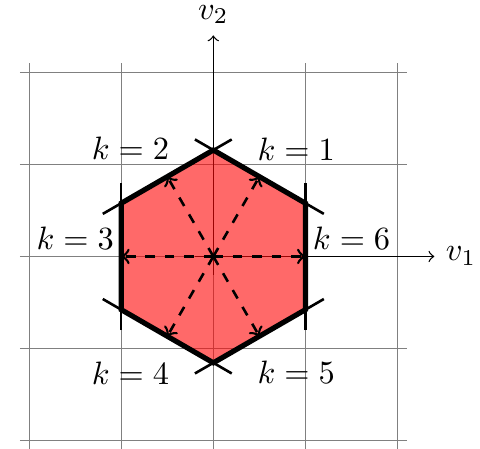
ξ ≤ kl pi , ∀ k ∈ 0 , k ∈ k 1